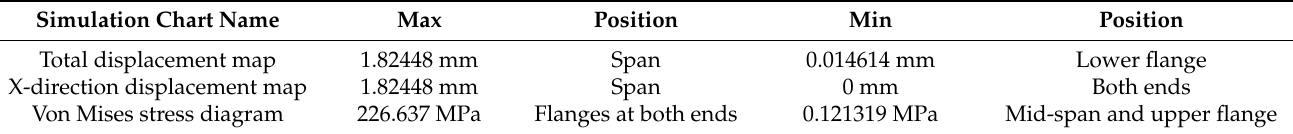
Table 2. Ansys numerical simulation results.